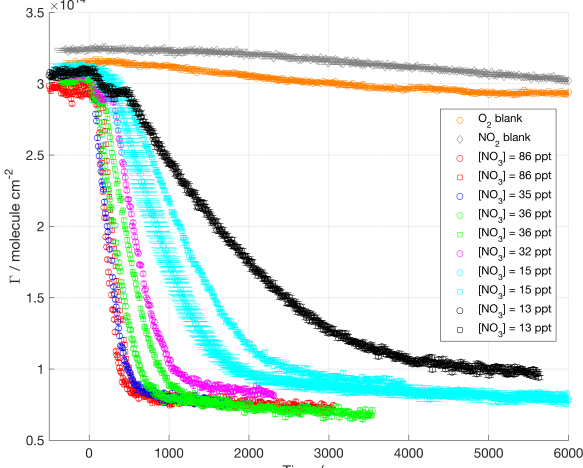
Figure 2. Surface excess decays of oleic acid ( d 34 OA) exposed to different [NO 3 ]; mean values of NO 3 mixing ratios are displayed in the legend (1ppt = 2 . 7 × 10 7 moleculecm − 3 ). NO 3 is admitted at t = 0s.